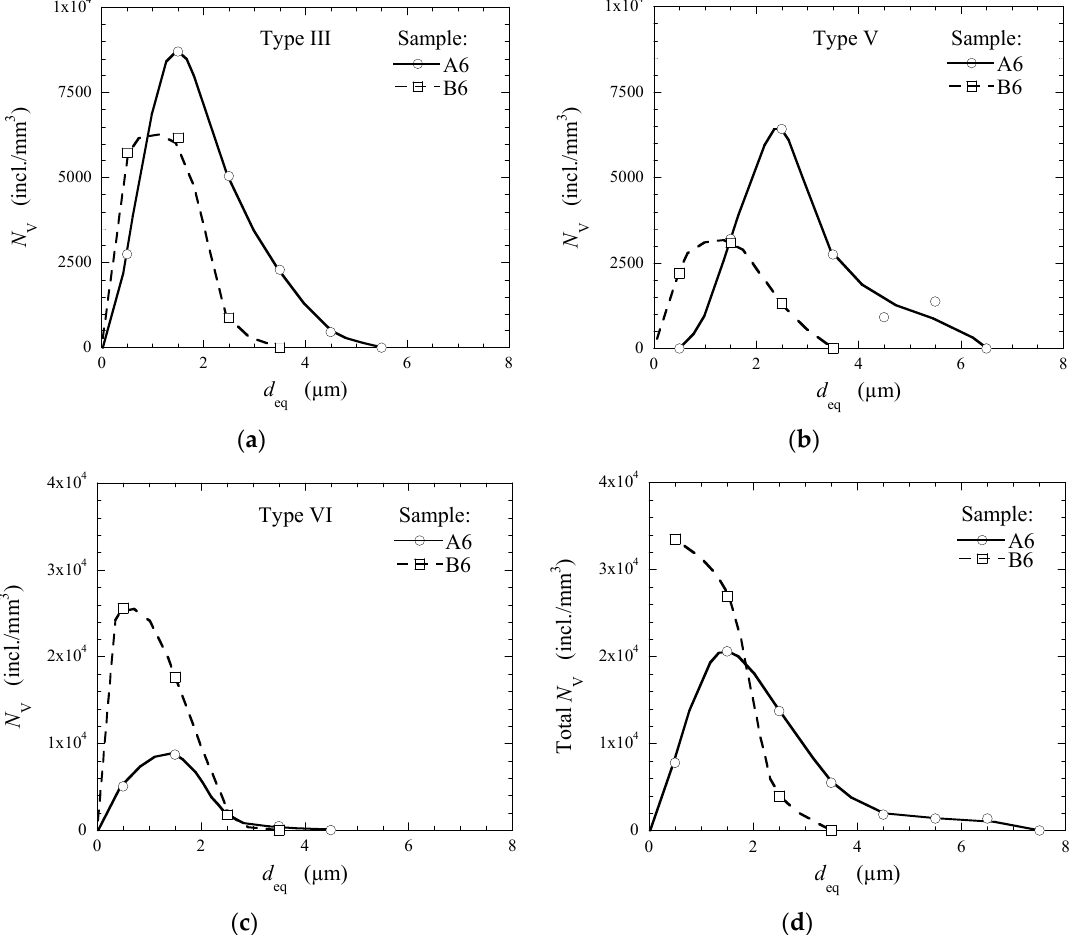
Figure 6. Particle size distributions for different non-metallic inclusions observed in the final products in Heat A and Heat B (samples A6 and B6): ( a ) Type III inclusions; ( b ) Type V inclusions; ( c ) Type VI inclusions; ( d ) all inclusions.